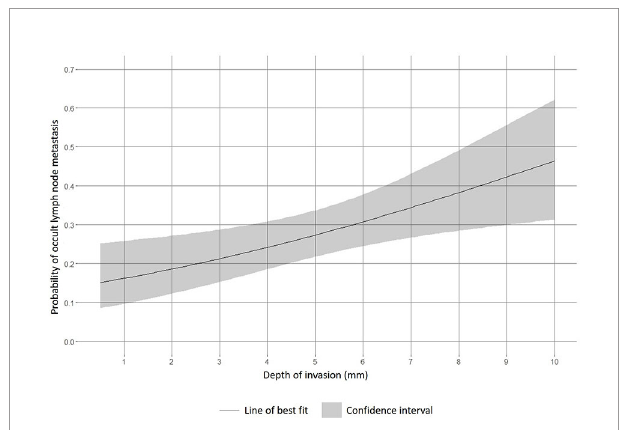
FIGURE 1 | Association between depth of invasion and occult lymph node